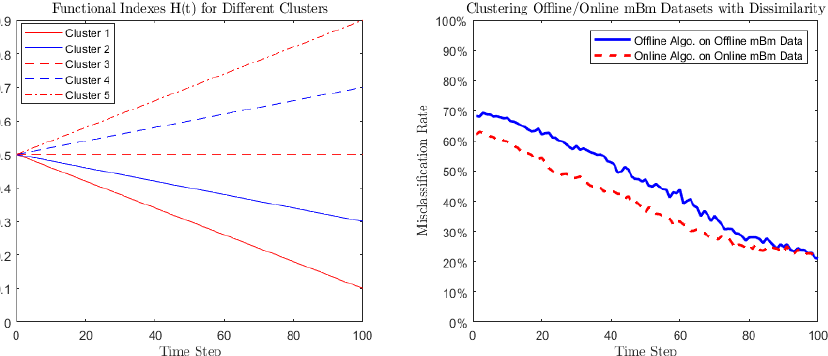
Figure 1. The functional form of H ( • ) follows Equation (73): H ( t ) = 0.5 + h i · t /100 with t = 0,1, . . . ,100. The left graph plots H ( • ) correspond to 5 different clusters. The right graph illustrates the misclassification rates output by (i) offline algorithm on offline dataset (solid line) and (ii) online algorithm on online dataset (dashed line). Both algorithms are performed based on the log ∗ - transformed covariance-based dissimilarity measure.